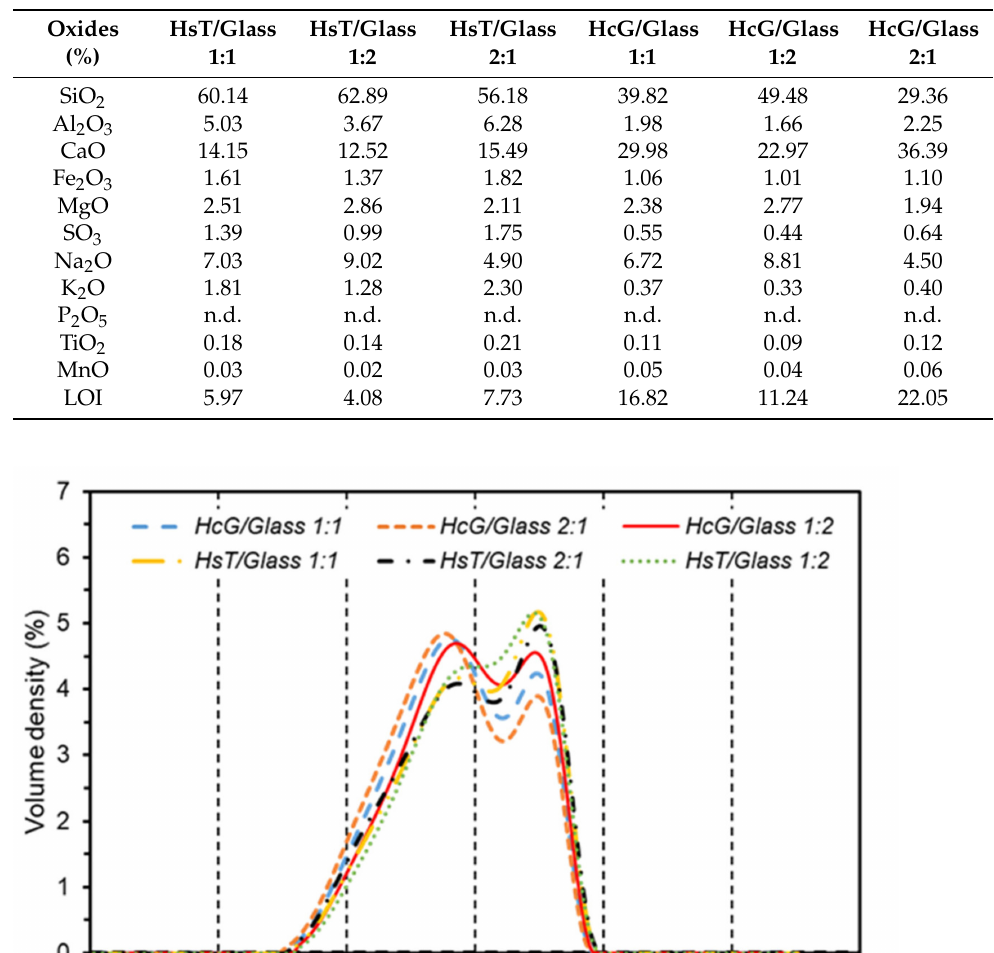
Table 1. Chemical composition by FRX of the binary pozzolans (n.d. = not detected).